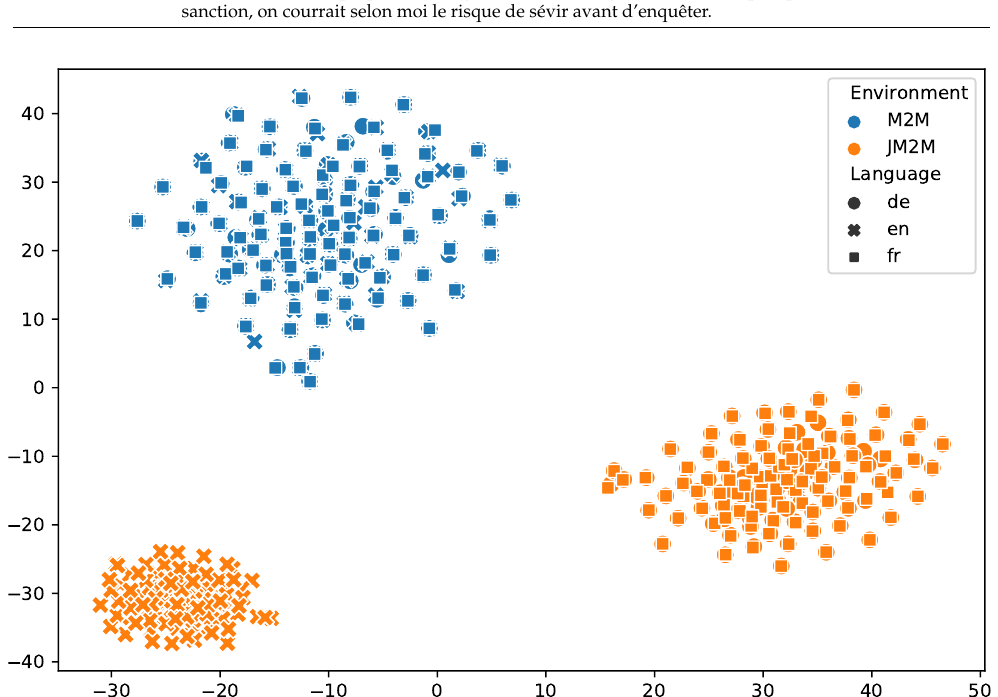
Figure 4. An interlingual representation of multi-parallel sentences from the M2 model trained in the M2M and JM2M